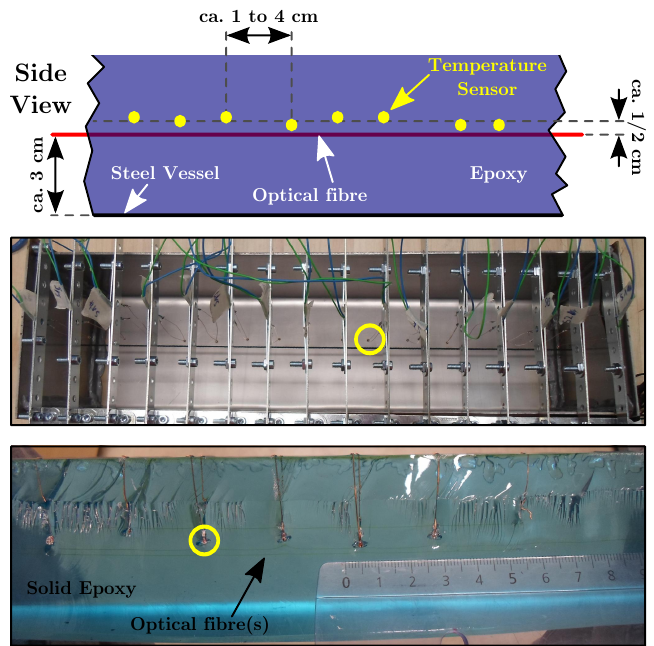
Figure 2. Schematic of the experimental setup for temperature measurements along the length of the optical fiber (upper image). Photo of the same empty 40cm long steel mold as in Figure 1 but with the temperature probes in place (middle image). Cross section of the solid epoxy block that was formed in the experiment, the setup of which is shown in the middle picture (lower image). The same temperature sensor marked in the middle picture is marked there, too. In the cross section image, the fiber(s) can be seen,